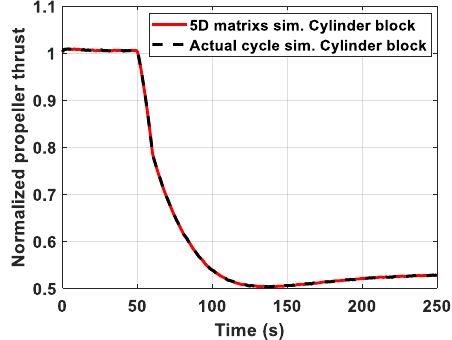
Figure 30. Propeller thrust time history.